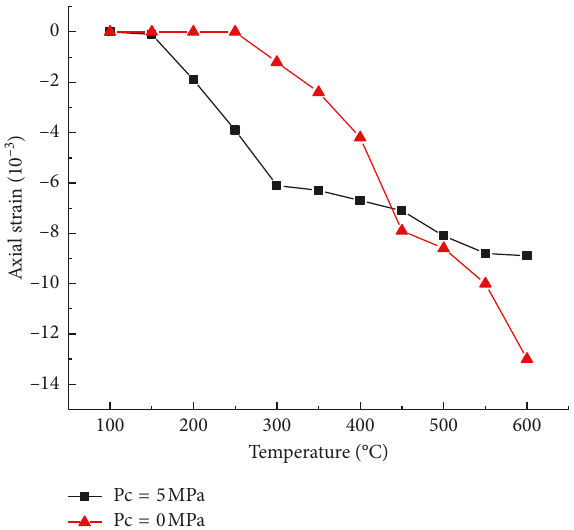
Figure 3: Axial strain change versus temperature under triaxial and uniaxial stress.